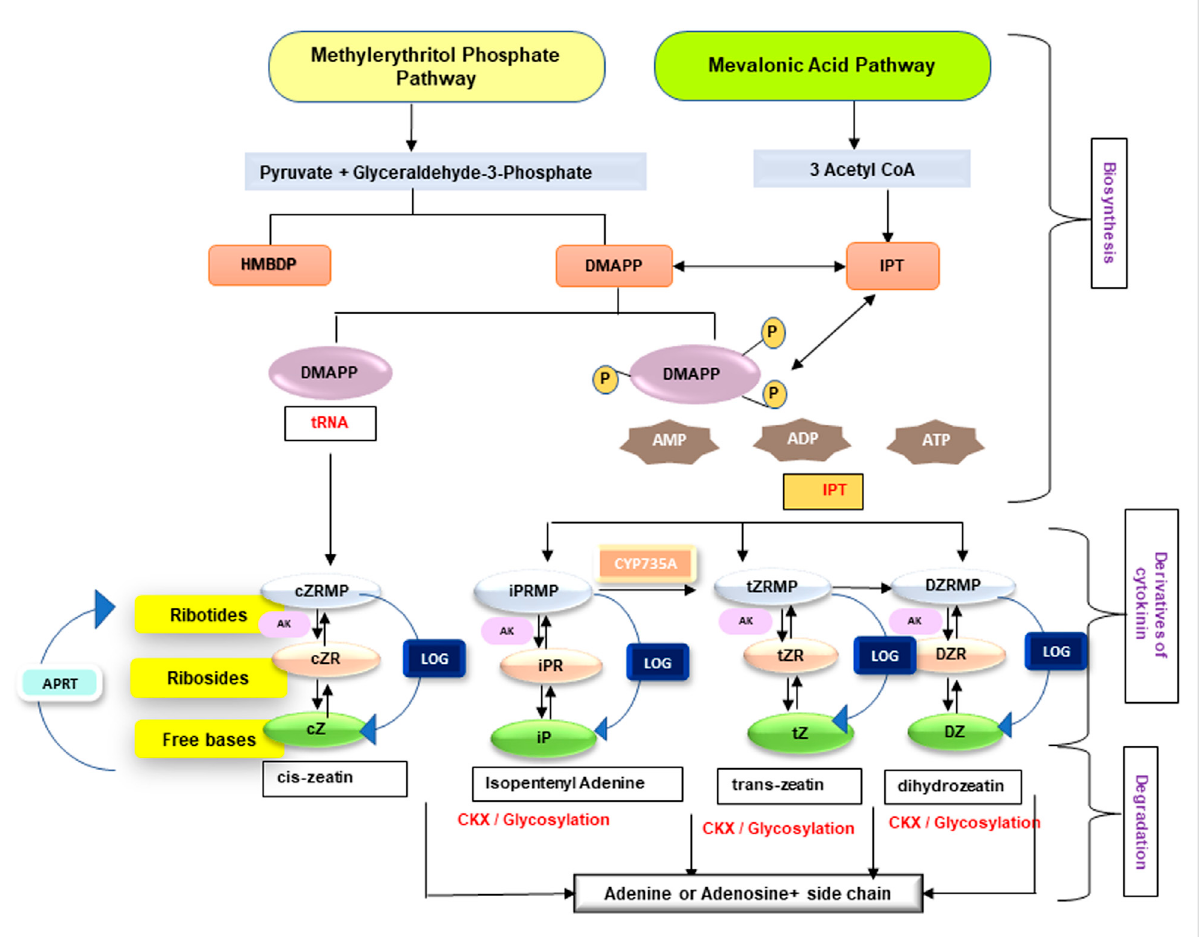
FIGURE 1 An overview on biosynthesis and enzymes of cytokinin homeostasis (iP, isopentenyladenine; DHZ, dihydrozeatin; cZ, cis-zeatin; tZ, trans- zeatin; DMAPP, dimethylallyl pyrophosphate; AMP, adenosine monophosphate) cytokinin biosynthetic pathways — mevalonic acid pathway (operates in cytosol and mitochondria) and methylerythritol pathway (operates in plastids). Enzymes involved are 1) IPT (isopentenyl transferase), which uses ATP, ADP, or ATP as acceptor and forms iPRTP (riboside 5 ′ -diphosphate), iPRDP (riboside 5 ′ -diphosphate), and iPRMP (riboside 5 ′ - monophosphate); 2) CYP735A converts CK nucleotides in to tZ nucleotides; 3) AK (adenosine kinase) causes the phosphorylation of ribosides iPR, tZR,cZR,andDZR;4)LOG(LONELYGUY)producesfreebasesfromribotides;5)APRT(adeninephosphoribosyltransferase)catalyzestheconversion of CK bases to nucleotides; and 6) CKX (cytokinin oxidase/dehydrogenase) causes catabolism of free bases (iP, tZ, DZ, and cZ) to adenine or adenosine (for references, see Takei et al., 2004; Kudo et al., 2010; Sakakibara 2006; Kurakawa et al., 2007; Schoor et al.,